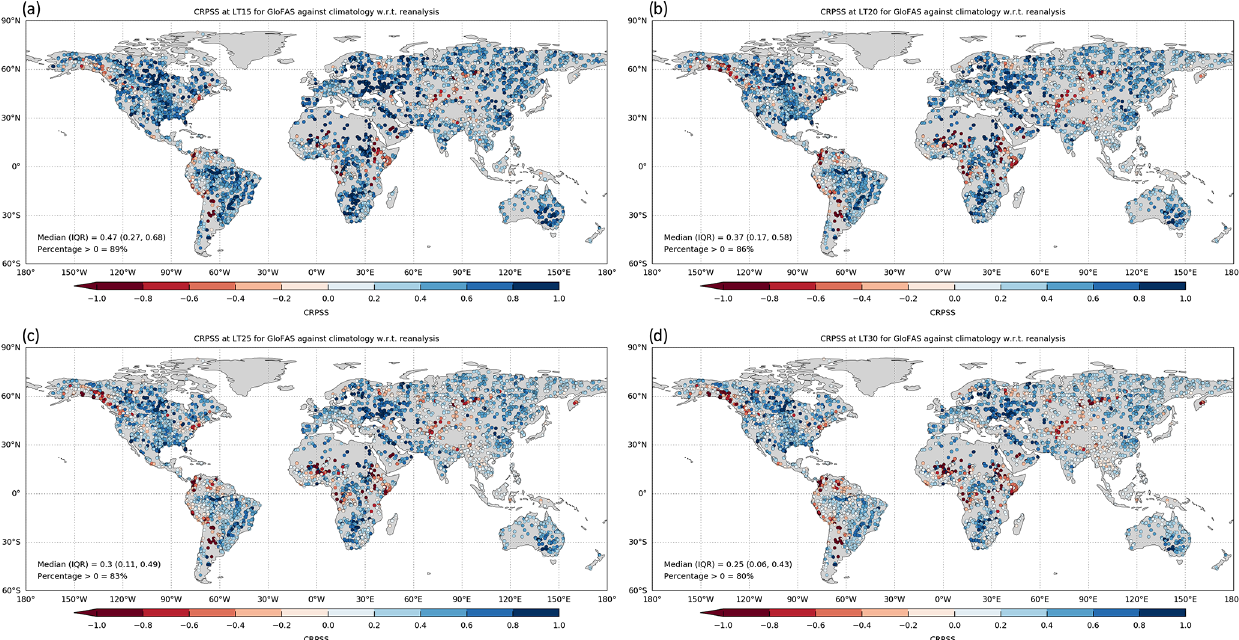
Figure 7. GloFAS 2.1/2.2 continuous ranked probability skill score (CRPSS) for reforecasts against the climatology benchmark for extended lead times – 15d (a) , 20d (b) , 25d (c) , and 30d (d) – with respect to GloFAS-ERA5 river discharge reanalysis at 5997 diagnostic river points. Optimum value of CRPSS is 1. Blue (red) dots show catchments with positive (negative) skill.